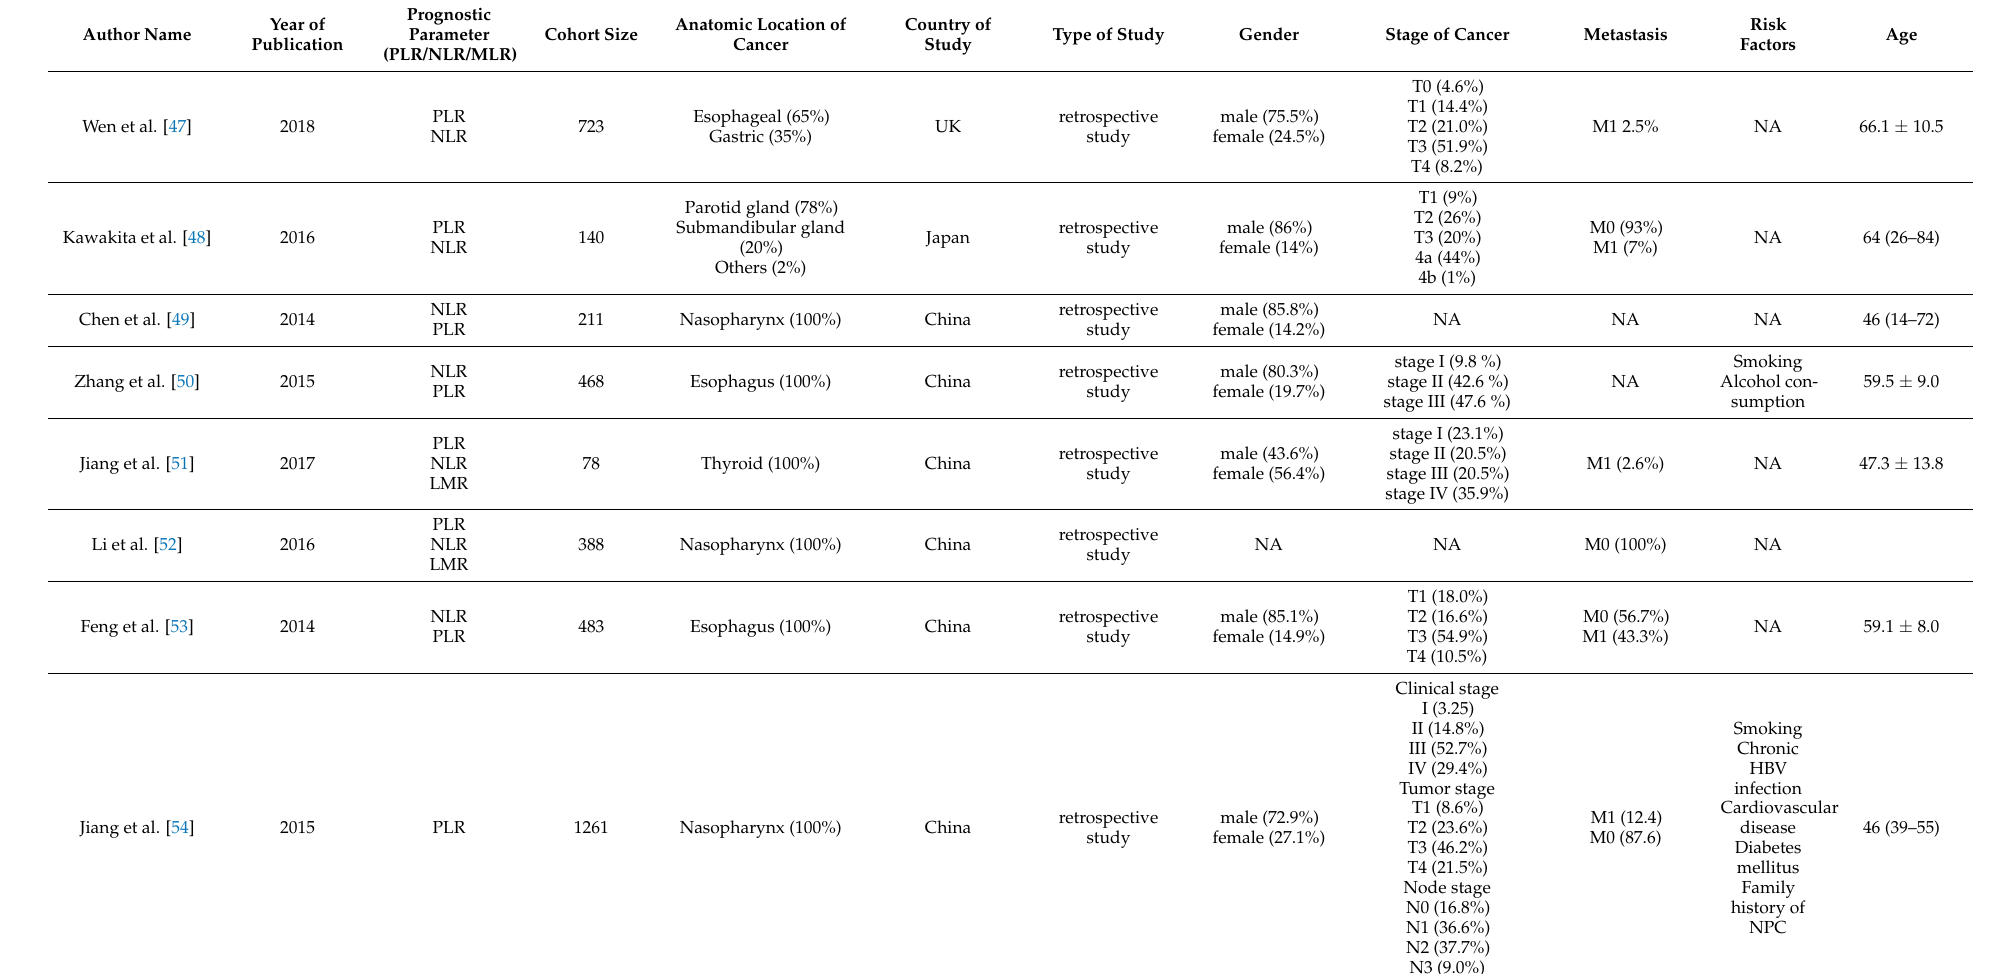
Table 1. Study characteristics of included studies for systematic